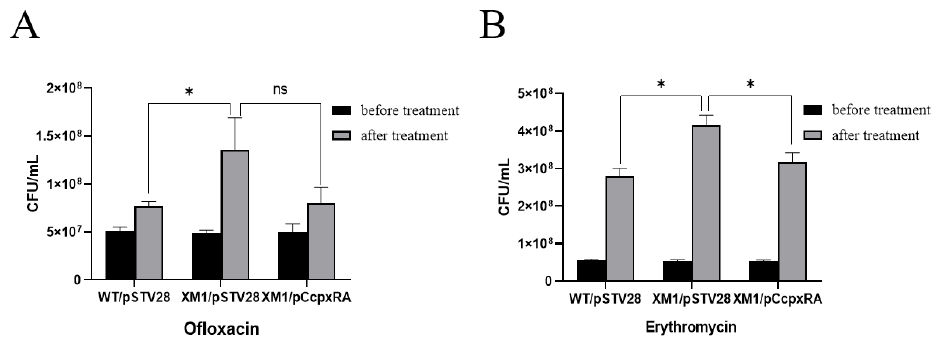
tibiotic pressures: ( A ) ofloxacin, ( B ) erythromycin. Error bars indicate SD; * represents p < 0.05, **